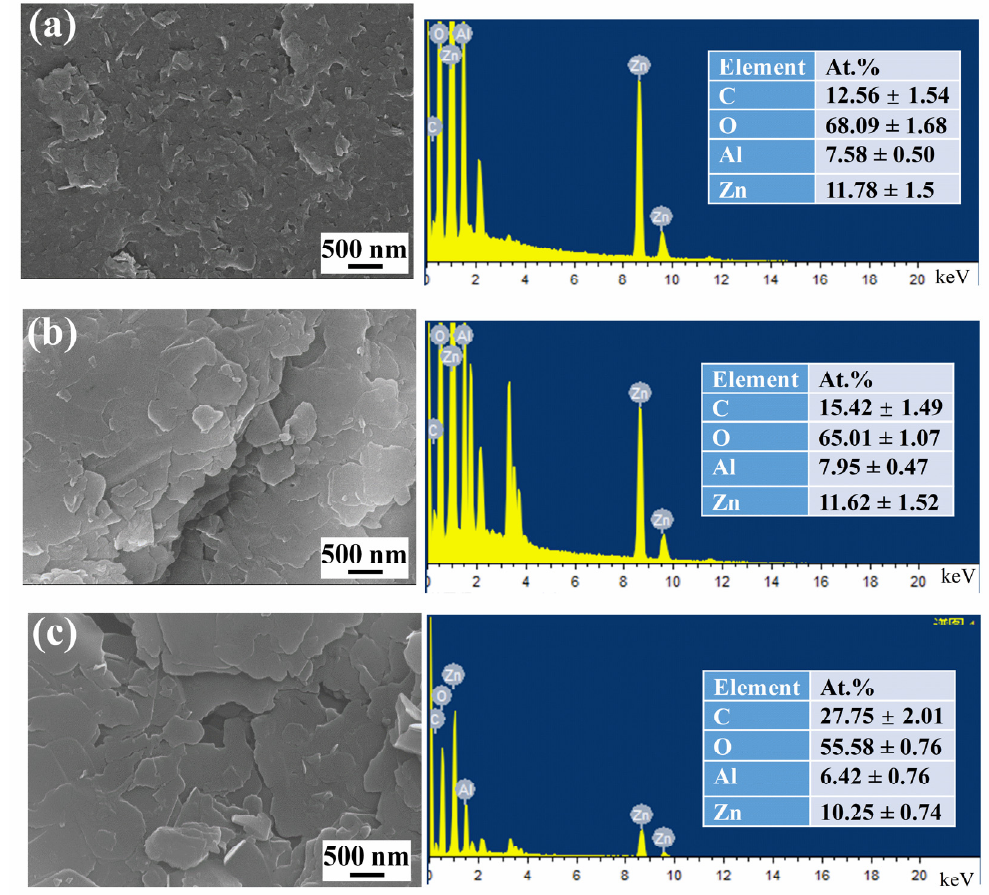
Figure 3. The SEM and corresponding EDS results of ( a ) Zn2Al1-LDH-6h, ( b ) Zn2Al1-LDH-15h, ( c ) Zn2Al1-LDH-24h.